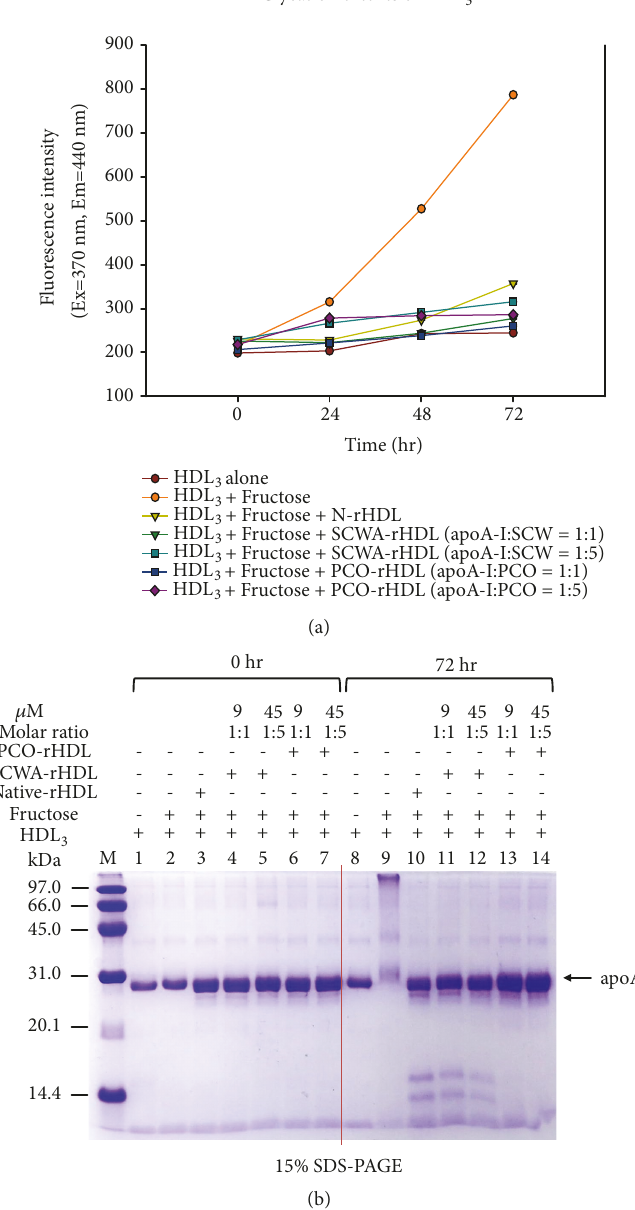
Figure 3: (a) Production of advanced glycation end products in HDL 3 by fructose treatment under presence of PCO-rHDL or SCWA-rHDL. (b) Electrophoretic patterns of HDL 3 after the fructose-mediated glycation (15% SDS-PAGE).